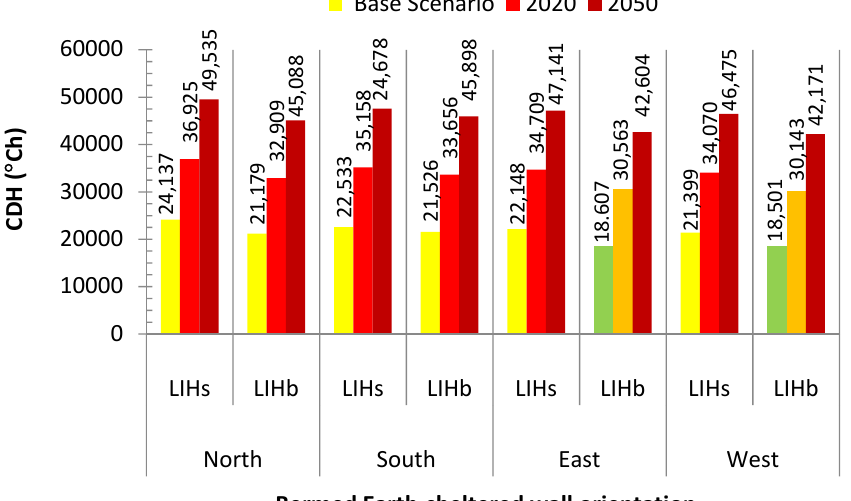
Figure 6. Weighted annual average Cooling Degree Hours indicator in baseline and future scenarios (color in East/West orientation on base scenario/2050s was changed to match with